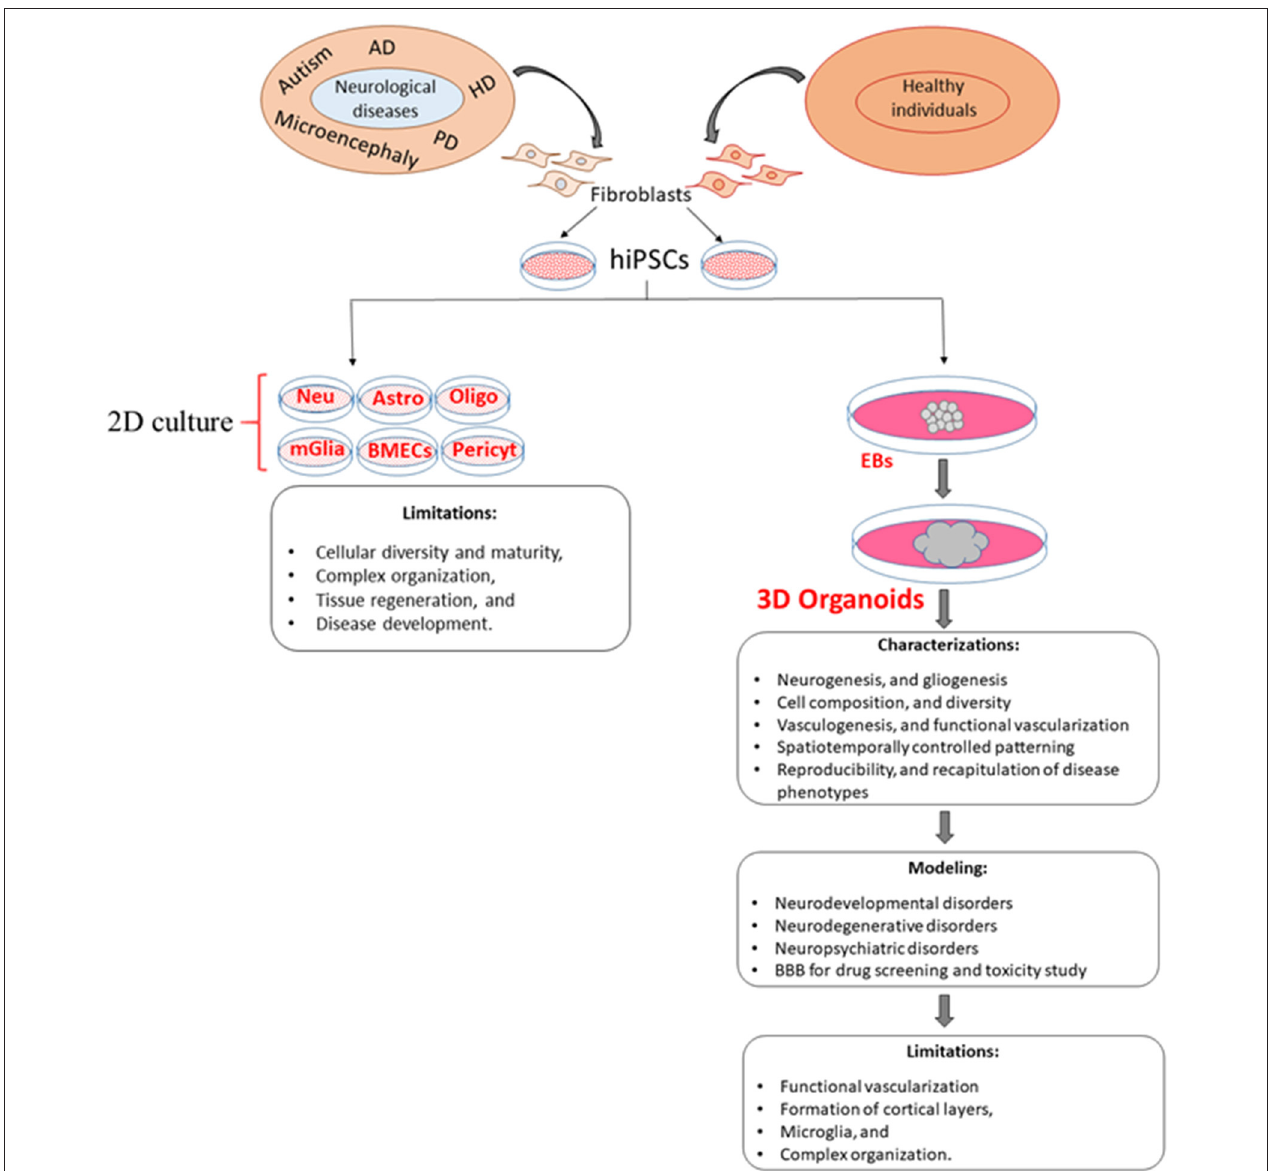
FIGURE 1 | Comparison of 2D and 3D cell culture models and their limitations. Although 3D models overcome some of the limitations of 2D models, the generation of new 3D models is needed to increase vascularization, cellular diversity, viability, and reproducibility as well as a more accurate recapitulation of disease phenotypes. EBs, embryoid bodies; Neu, Neuron; Astro, astrocytes; Oligo, oligodendrocyte; mGlia, microglia; BMECs, brain microvascular endothelial cells; Pericyt,